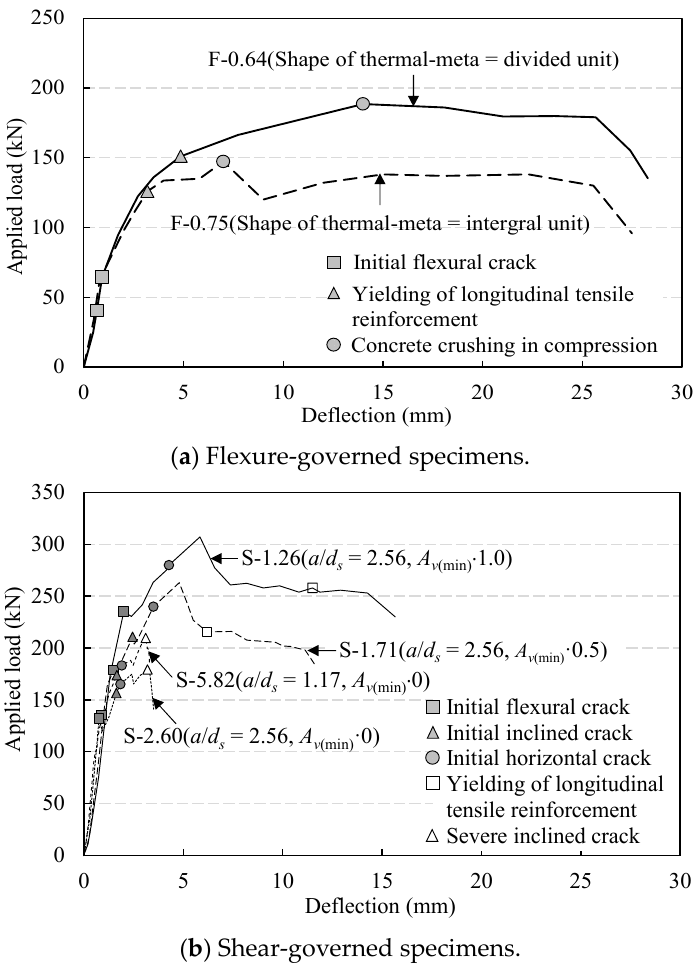
Figure 7. Applied load–deflection relationship.